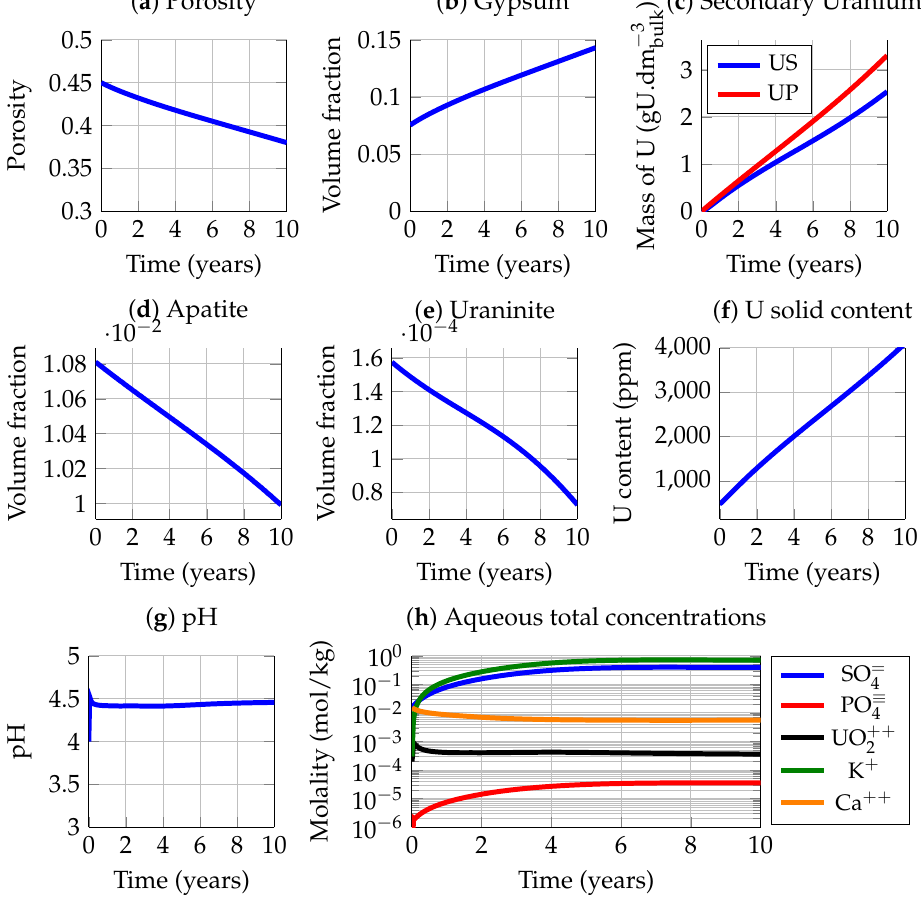
Figure 5. Transient evolution within the gypcrete. ( a ) Porosity. ( b – e ) Mineralogy evolution. ( f ) U content in the solid phase. ( g ) Porewater pH. ( h ) Porewater